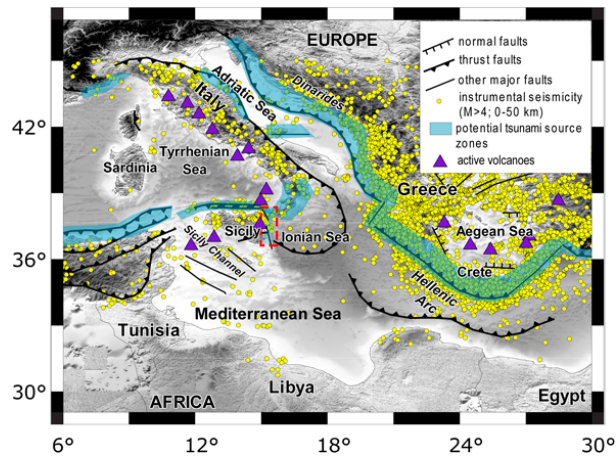
Fig. 1. Tectonic sketch map of the central-eastern Mediterranean basin. The red dashed rectangle locates the study area. Instrumen- tal seismicity (yellow dots; M > 4; depth 0–50km) is taken from the ISC Catalogue (ISC, 2004). Colour-shaded zones highlight the main structures capable of generating tsunamis that pose a signifi- cant hazard to Mediterranean shore-facing settlements (modified af- ter Lorito et al., 2008). Active volcanoes are taken from the database developed within the EU TRANFER Project STREP (n.